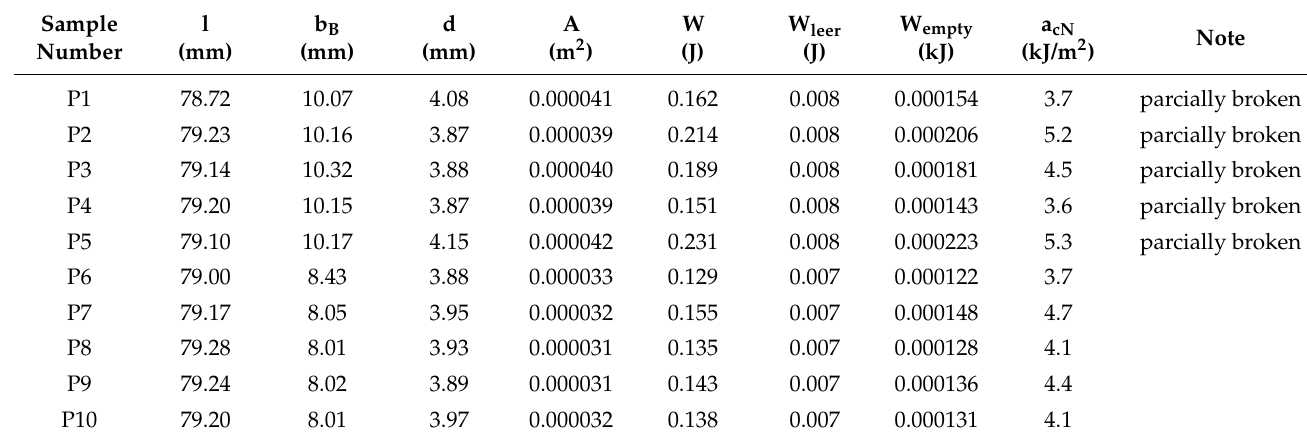
Table A24. Results of the notched impact tests and unnotched impact tests of P.